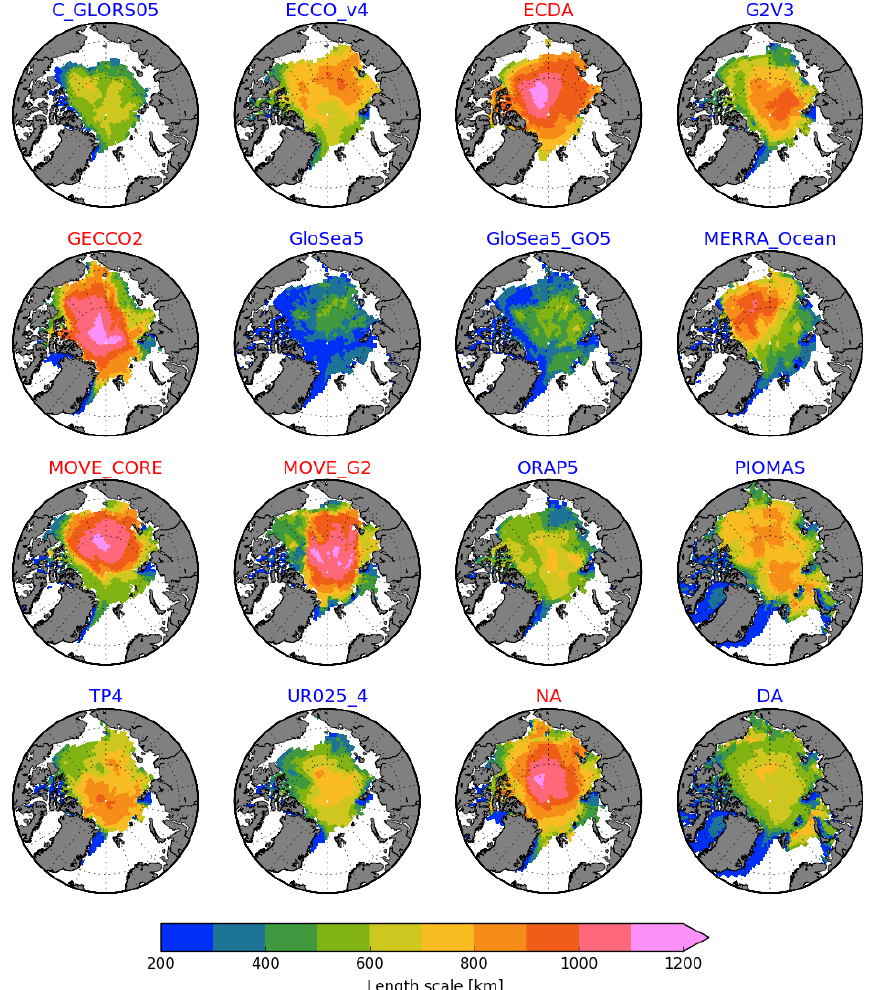
Figure 8. The e -folding length scales estimated for the SIT time series. Only grid cells in which the time-mean (for the January 1993– December 2007 period) SIT at the time of summer minimum is greater than 0.1m are taken into account for the computations. Averages for the systems with ice data assimilation and no data assimilation are represented by the DA and NA panels, respectively. All maps have the 0 ◦ longitude placed at 06:00, while the bounding latitude is 67 ◦ N. Reanalyses labeled in blue and red highlight whether the datasets were built with or without ice data assimilation,